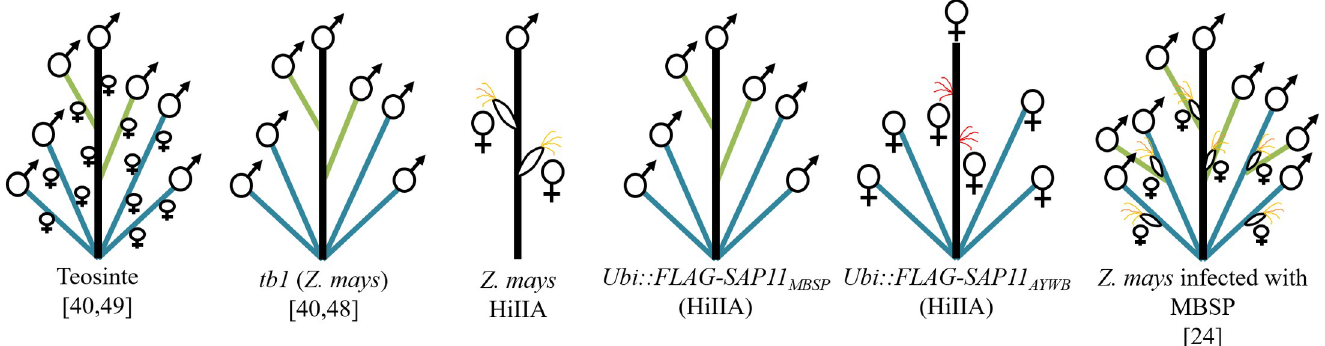
Fig 6. Schematic presentation of phenotypes of WT maize ( Z . mays ), tb1 maize, Ubi :: FLAG-SAP11 and MBSP-infected maize plants. Schematic presentations of the phenotypes of teosinte and tb1 are included as comparison [40,48,49]. tb1 resembles teosinte architecture but has impaired development of female inflorescences. Ubi :: FLAG-SAP11 MBSP plants phenocopy tb1 plants. Ubi :: FLAG-SAP11 AYWB plants produce more tillers with female inflorescences and naked ears from the main culm, and are male sterile. MBSP-infected maize plants (right) produce more tillers and small ears with few kernels [24] (see text for further explanation). Main culms are indicated in black, axillary branches in green, tillers in blue, silks directly emerging from the main culm in red, silks of ears in yellow and inflorescences in symbols ( ♂ , male; ♀ , female).